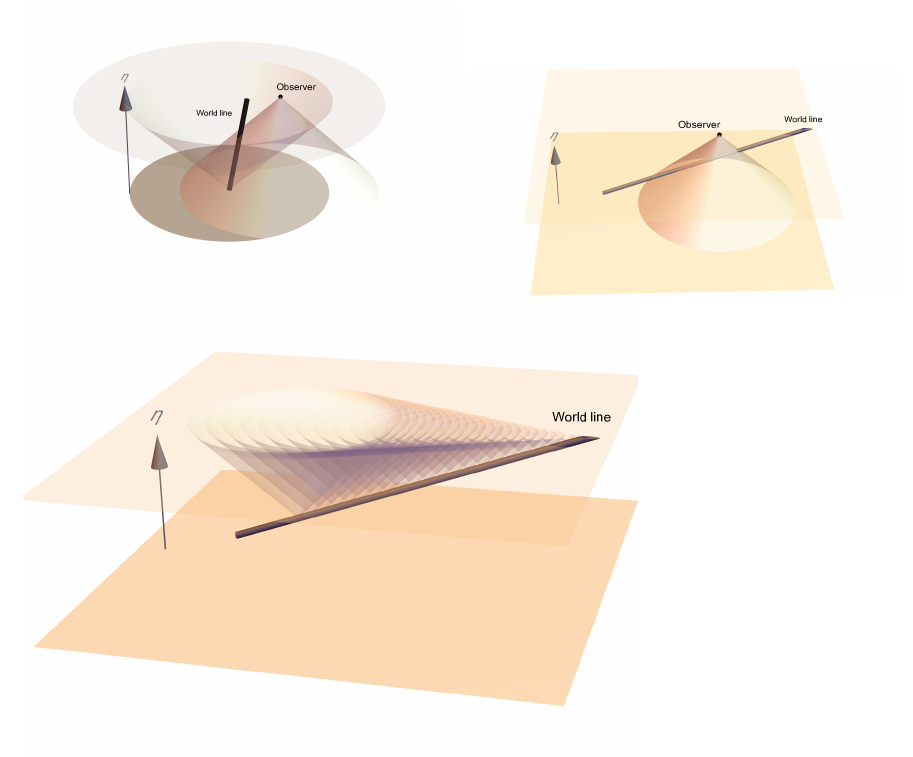
Figure 1. Cherenkov radiation: spacetime perspective. In all the above figures, we employ the ( η , (cid:126) y ) coordinate system on the right hand side of Equation (5); with time running upwards. On the top left panel, we illustrate the fact that, for an observer on some constant η > 0 surface (top disk), as long as she is situated within the acoustic particle horizon of the source–whose world tube is the black thick line–there will always be a non-trivial signal because her past null cone will necessarily intersect with it. The dark disk lies on the η = 0 + surface infinitesimally near the Big Bang, and its radius corresponds to the size of the horizon: it is the same radius of the intersection region between the top constant η surface with the forward light cone of the source at η → 0 + . On the top right panel, we turn to consider instead a spacelike source. We see that such a world tube would generically intersect the observer’s past null cone at two locations, corresponding to two ‘retarded times’. Only when the world tube is tangent to the null cone does the two reduce to one; the observer is then located on the Cherenkov cone which clearly divides space into a signal-free and a non-zero signal region. To see this, we move on to the bottom panel, where we have the same spacelike source’s world tube, but attach forward null cones on various points along it. The Cherenkov shock front for a fixed η > 0 surface is the envelope of the locus of all such null cones emanating from the world